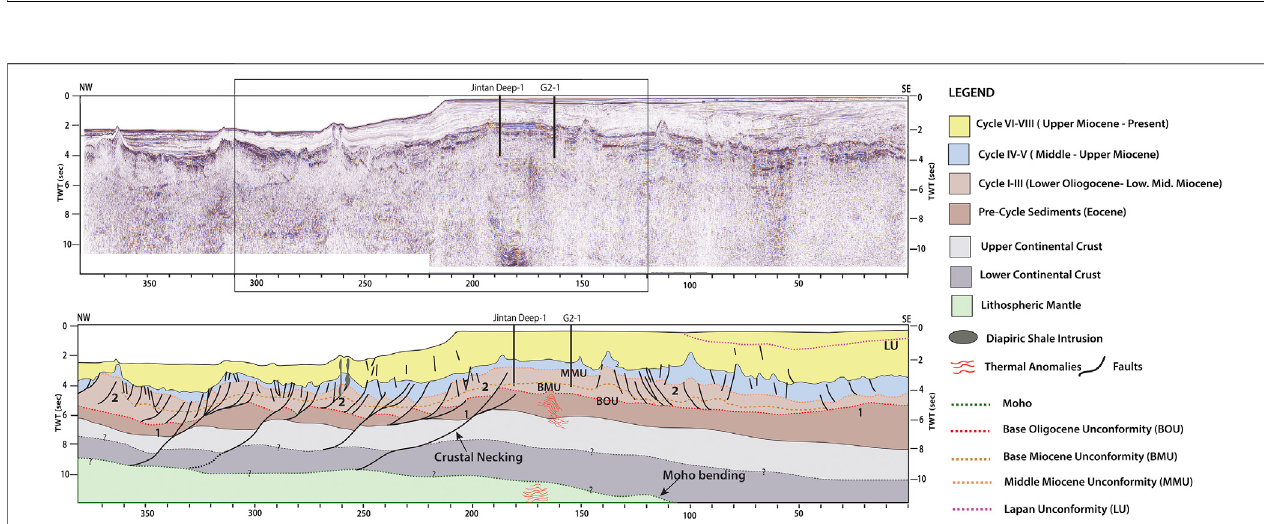
FIGURE4| UninterpretedandinterpretedseismiclineacrossN-SofLuconiaProvince.Thenorthernpartishavinglowangledetachmentfaultsandthinnercrustin boudinageshapeswhilethesouthernpartexhibithighanglenormalfaultsandthickercrust.Thermalanomaliesareobservedatpointofcrustalneckingbetweenshallow and deep-water section with Moho seen to bend into the subsurface. Location of the line is shown in Figure 1B . Rectangle box is representing the zoom in section for Figure 6 . Numbering 1 and 2 are corresponding to the tectonic events discussed in this paper.